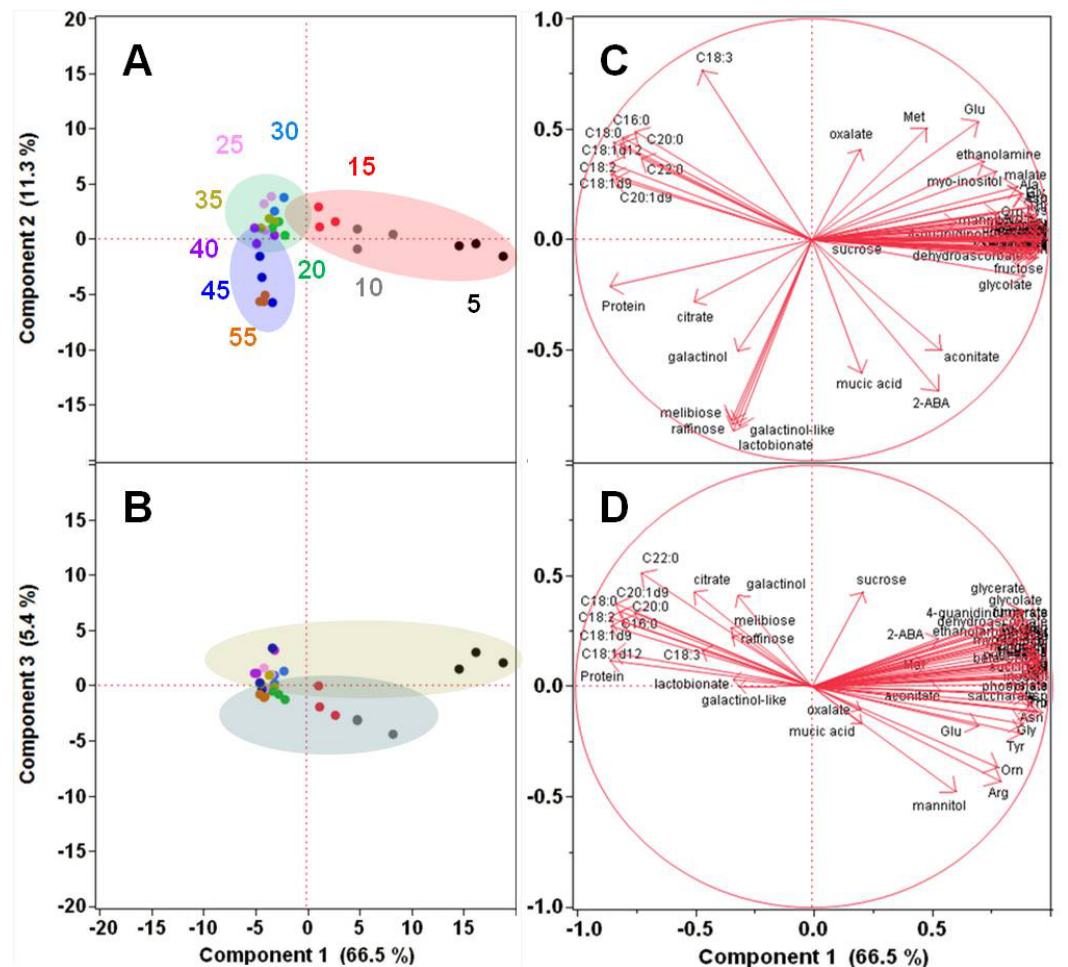
Figure 2. Principal Component Analysis on Metabolite Level Correlations. Score plots (A and B) and loading plots (C and D) are shown for combinations of PC1, 2, and 3. PCA was performed on combined non-redundant data involving three replicates of the relative or absolute levels of free metabolites, individual fatty acids from hydrolyzed lipids, and hydrophobic protein in developing soybean embryos by using JMP Pro 10 software (SAS, Cary, NC, USA). The color-coded numbers in A represent the corresponding age of the embryos (days 5 through 55), and each dot of the same color represents replicate samples. The color-coding is retained for B. The ovals highlight the basic clustering/separation of similar/dissimilar samples. In the loading plots C and D, the eigenvectors represented by red arrows show how (the direction) and how much (the length) each metabolite contributes to the individual correlations represented by PC1, 2, and